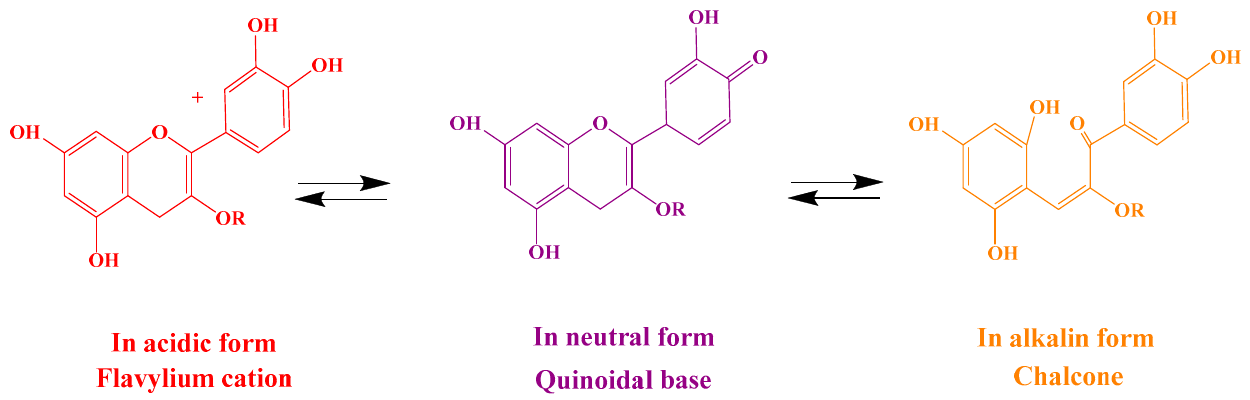
Figure 4. Appearance of halochromic smart indicators ( A1 : G/ChNFs/BAs, B1 : G/ChNFs/SPAs) compared to G/ChNFs; solution color variations of BAs ( A2 ) and SPAs ( B2 ); halochromic smart indicators’ color changes when incubated in various buffer solutions: ( A3 ) G/ChNFs/BAs and ( B3 ) G/ChNFs/SPAs.